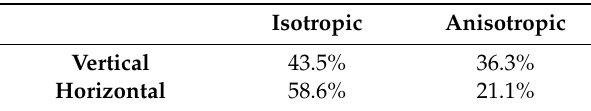
Table 4. Average error (%) for the vertical and horizontal test coupon experimental and simulation data for the isotropic and the anisotropic plasticity